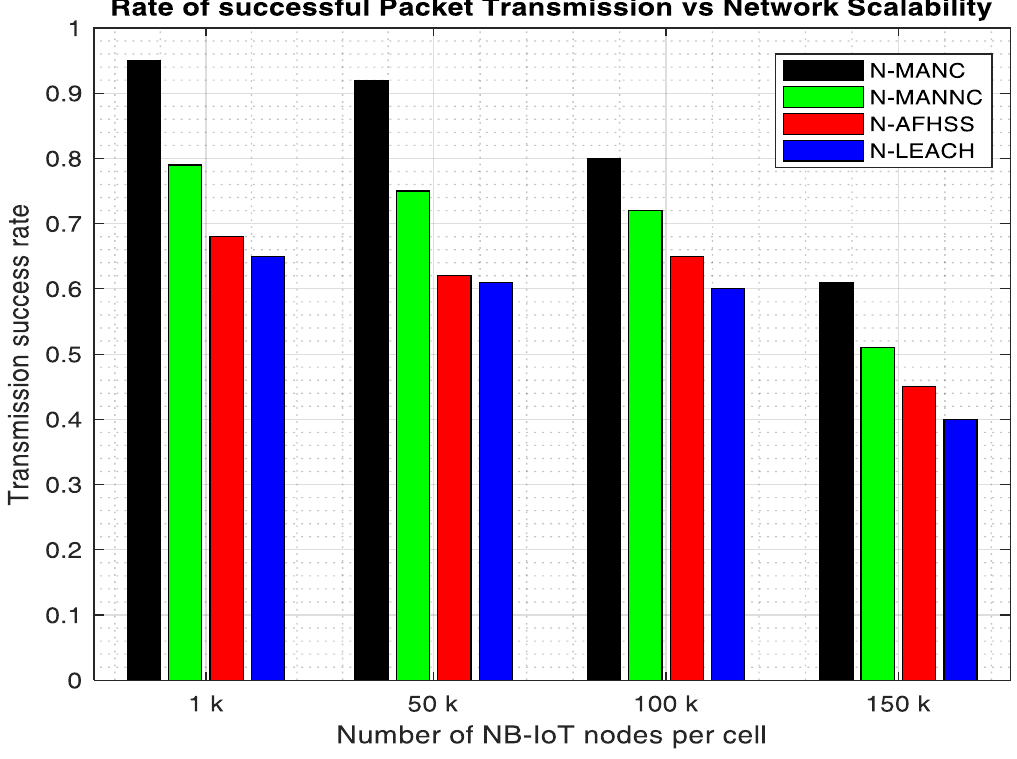
Figure 5. Packets transmission success rate versus network